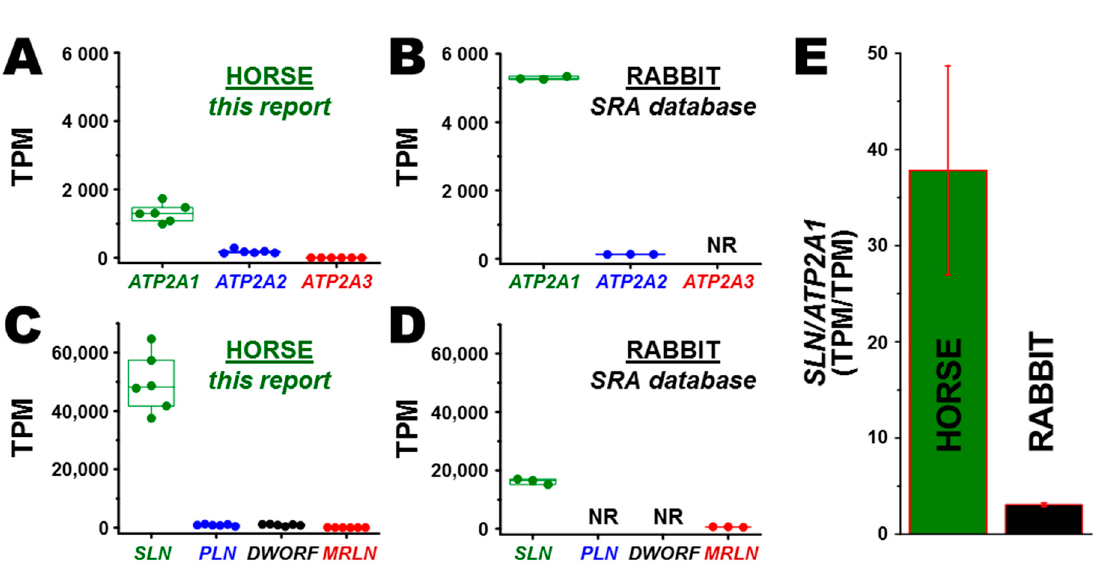
Figure 1. RNA-seq quantitation of gene transcription for calcium regulatory proteins in horse muscle. ( A – D ) The number of target transcripts per million reads (TPM) are reported, using a box plot to indicate the median, maximum, minimum, and range (N = 6 Arabian horses and N = 3 rabbits). ( A , B ) ATP2A1 (SERCA1), ATP2A2 (SERCA2), and ATP2A3 (SERCA3) in horse gluteus and rabbit muscle, respectively. ( C , D ) SLN , PLN , DWORF , and MRLN in horse gluteus and rabbit muscle, respectively. ( E ) The relative ratio of transcript / transcript expression (TPM / TPM) of SLN to ATP2A1 in horse gluteus and rabbit muscle, respectively. The expression level of horse genes was mined from RNA-seq data with SRA accession number SRP082284. The expression level of rabbit genes were mined from RNA-seq data reported with SRA accession number SAMN00013649. ( D ) NR indicates “data not reported” for rabbit gene transcripts in the SRA database.